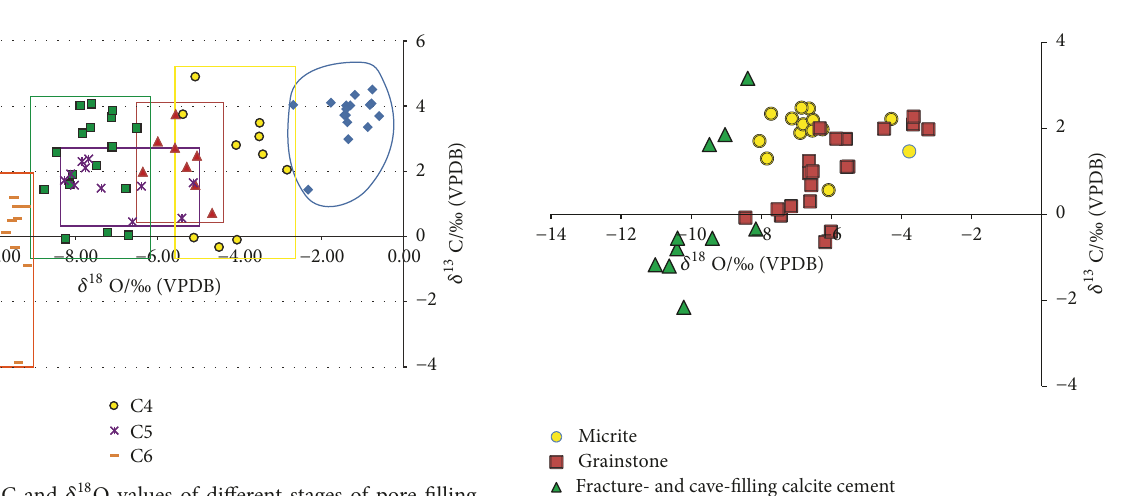
Figure 7: 𝛿 13 C and 𝛿 18 O values of different stages of pore-filling calcite cement by in situ SIMS. Figure 8: 𝛿 13 C and 𝛿 18 O values of host rocks and fracture- and cave- filling calcite cement by conventional